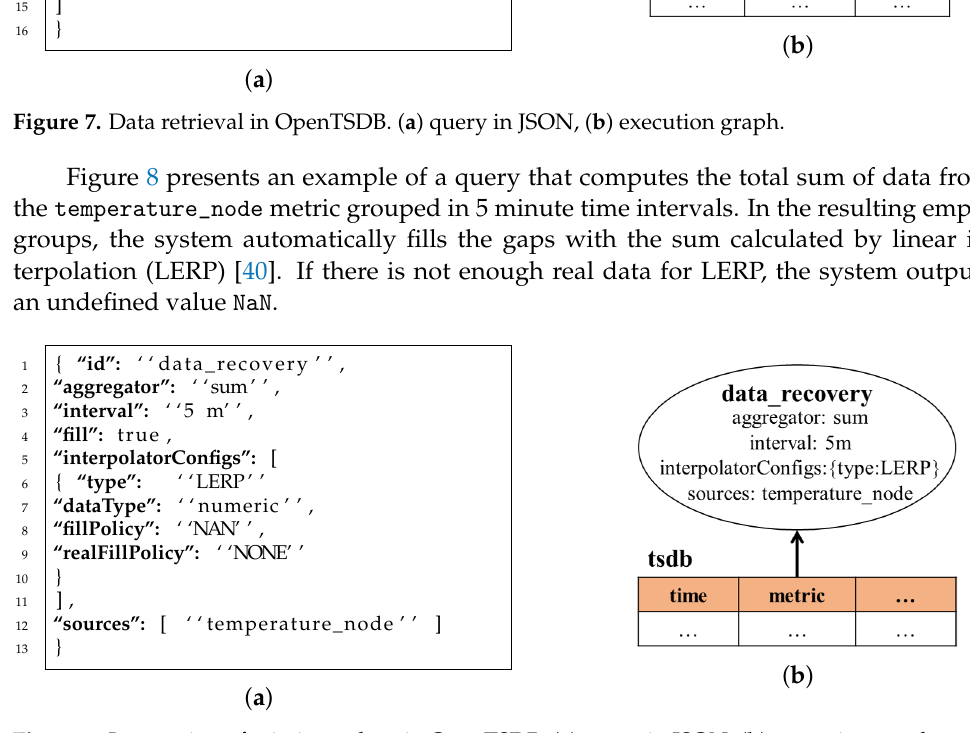
Figure 8. Imputation of missing values in OpenTSDB. ( a ) query in JSON, ( b ) execution